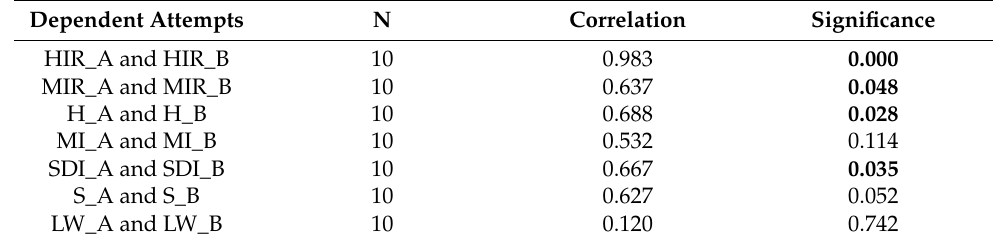
Table 3. Pearson’s correlation coefficients.